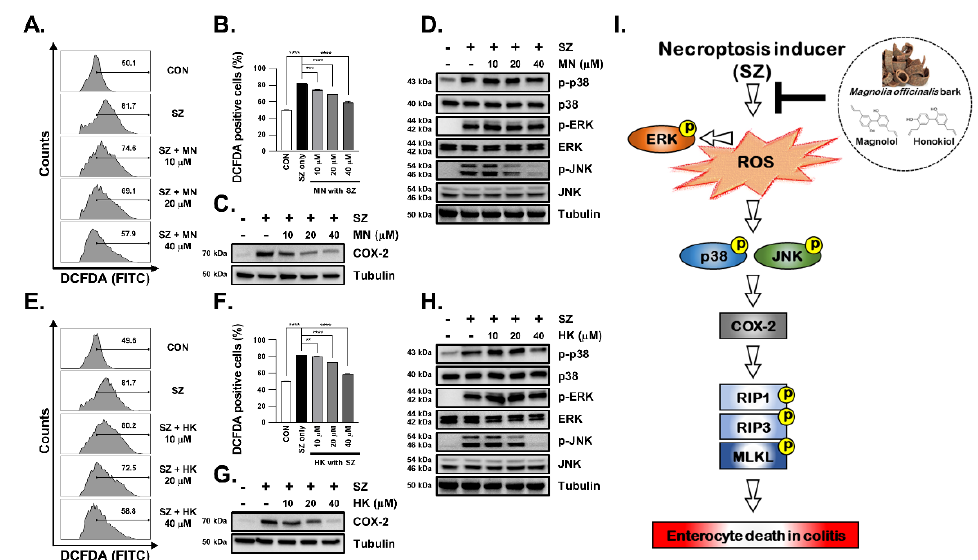
Figure 7. MN and HK attenuate ROS-dependent necroptosis. HT29 cells were pretreated with indicated concentrations of MN ( A ) and HK ( E ) for 30 min before the treatment with SZ (Smac mimetic (100 nM) and z-VAD (20 µM)) for 12 h. Intracellular ROS was detected as DCFDA fluorescence using flow cytometry. ( B , F ) The number indicates increased DCFDA fluorescence in ( A ) and ( E ), respectively. ( C , G ) The protein expression of COX2 was analyzed using western blotting. Tubulin was used as a loading control. ( D , H ) The protein levels of p38, p38, pERK, ERK, pJNK, and JNK were analyzed using western blotting. Tubulin was used as a loading control. ** p < 0.01, *** p < 0.001 and **** p < 0.0001 (data were analyzed using an ANOVA). ( I ) Schematic diagram of the inhibition of the necroptosis pathway by MBE, MN, and HK.